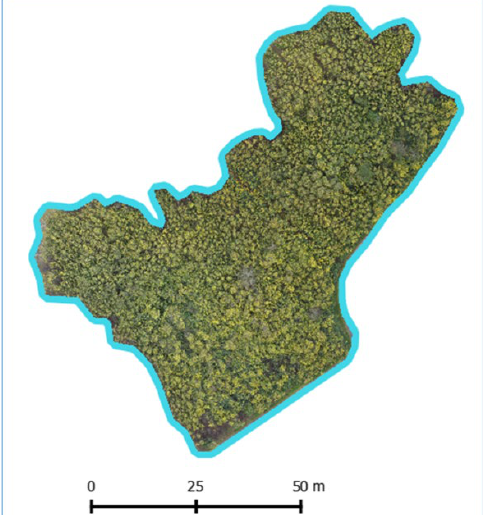
Figure 5 Training area delineation. This footprint is to be used as an overlay of the satellite images.